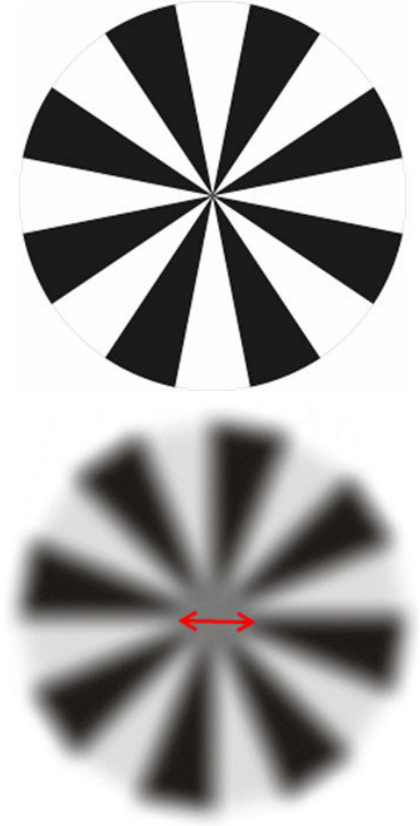
Figure 7. Siemens star Target in its theoretical form (top image) and imaged (lower image) with the blurred area visible in the